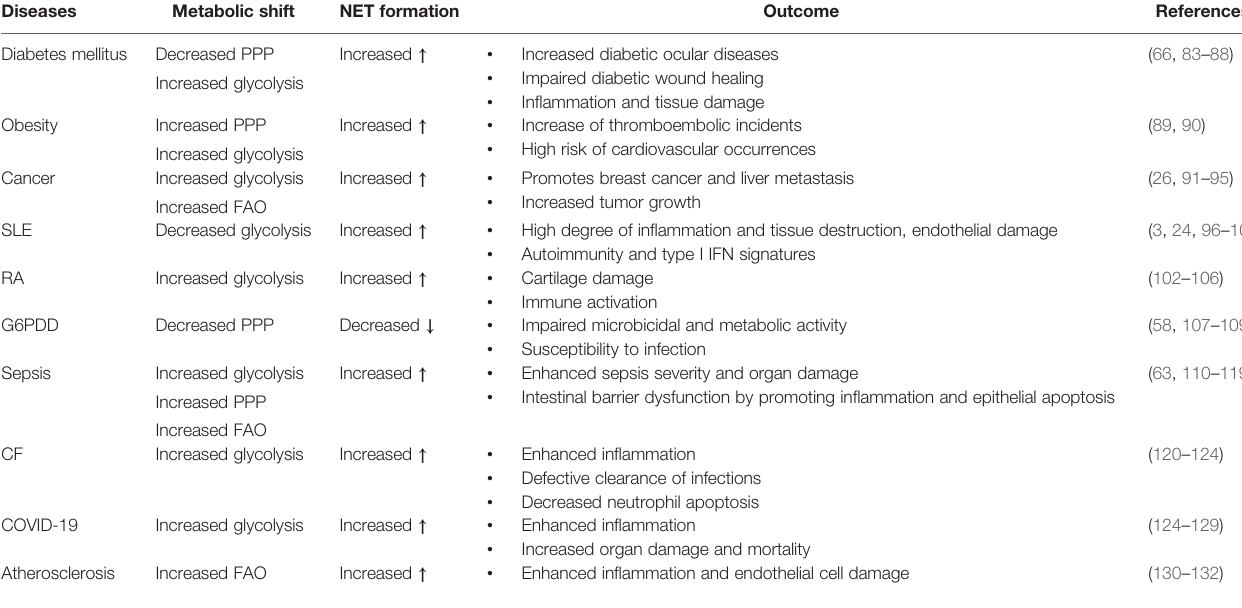
TABLE 1 | Metabolic changes in NET-associated